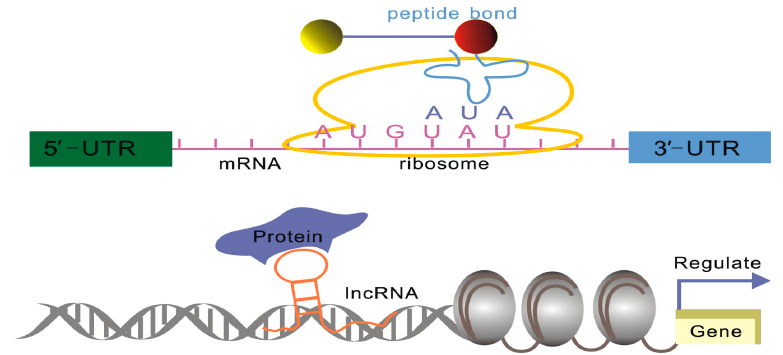
Figure 1. Differences in the structure and sequence between mRNA and lncRNA. The mRNA primary coding sequence (CDS) plays a significant role in the translation, while lncRNAs regulate target gene expression through the interactions between their higher-order structures and major partner proteins.